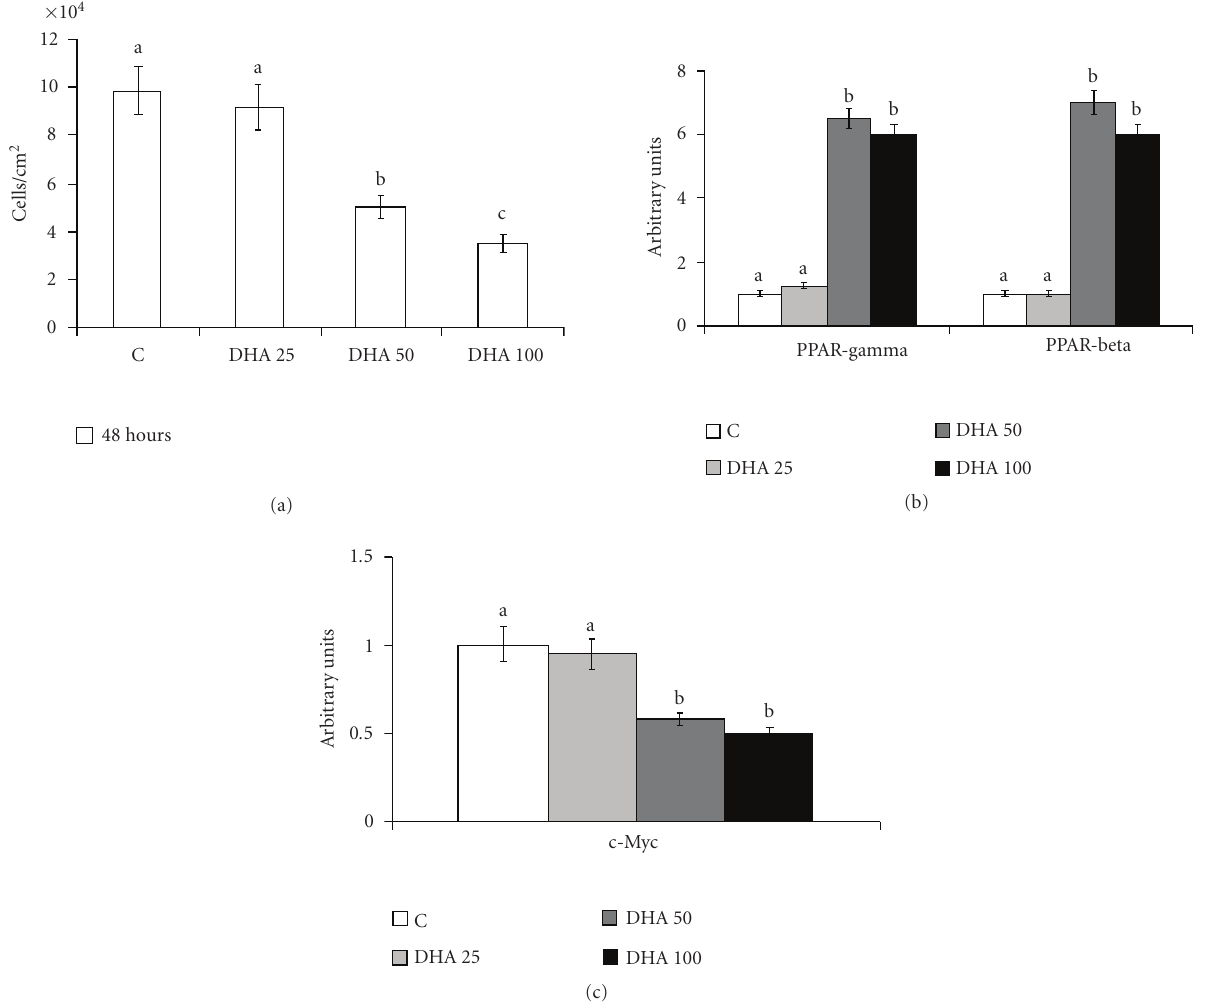
Figure 3: Cell growth, and PPAR γ , PPAR β , and c-Myc protein contents, in human lung tumor A549 cells treated with DHA. (a) Cell growth: 24 hours after seeding, cells were treated with 50 μ M of DHA for a further 48 hours. Control cells were treated with vehicle alone. The number of cells/cm 2 counted in the monolayer is represented as mean ± SD of 3 experiments. (b) Protein content of PPAR γ , PPAR β , and (c) c-Myc: protein content was determined by Western blot analysis. The densitometry value given for each protein referred to the corresponding β - actin value and was expressed by arbitrarily normalizing the control value to 1. Means with di ff erent letters are significantly di ff erent from one another ( P < . 05) as determined by analysis of variance followed by post hoc Newman-Keuls